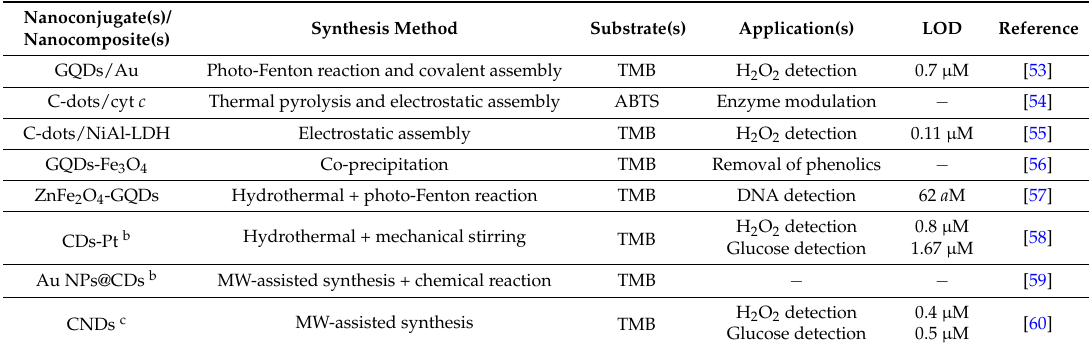
Table 2. POD-like activity of GQDs/C-dots conjugates or nanocomposites and carbon nitride (CN) dots a . Nanoconjugate(s)/